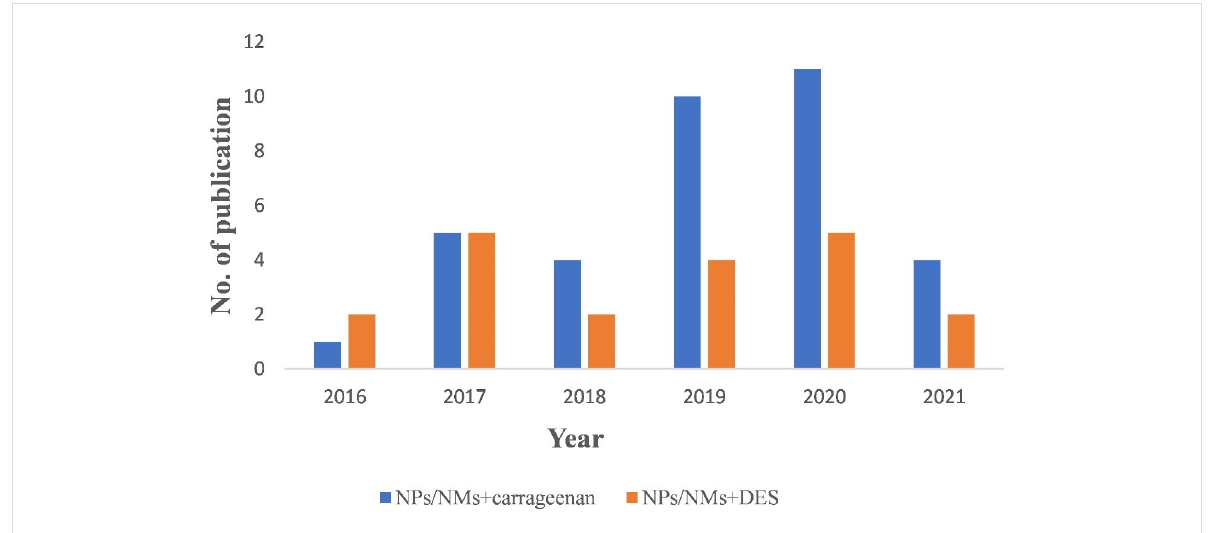
Figure 1: Number of publications over the last five years on the synthesis of nanoparticles (NPs)/nanomaterials (NMs) using carrageenan and a deep eutectic solvent (DES). The numbers have been obtained from SCOPUS-indexed journals using PubMed.